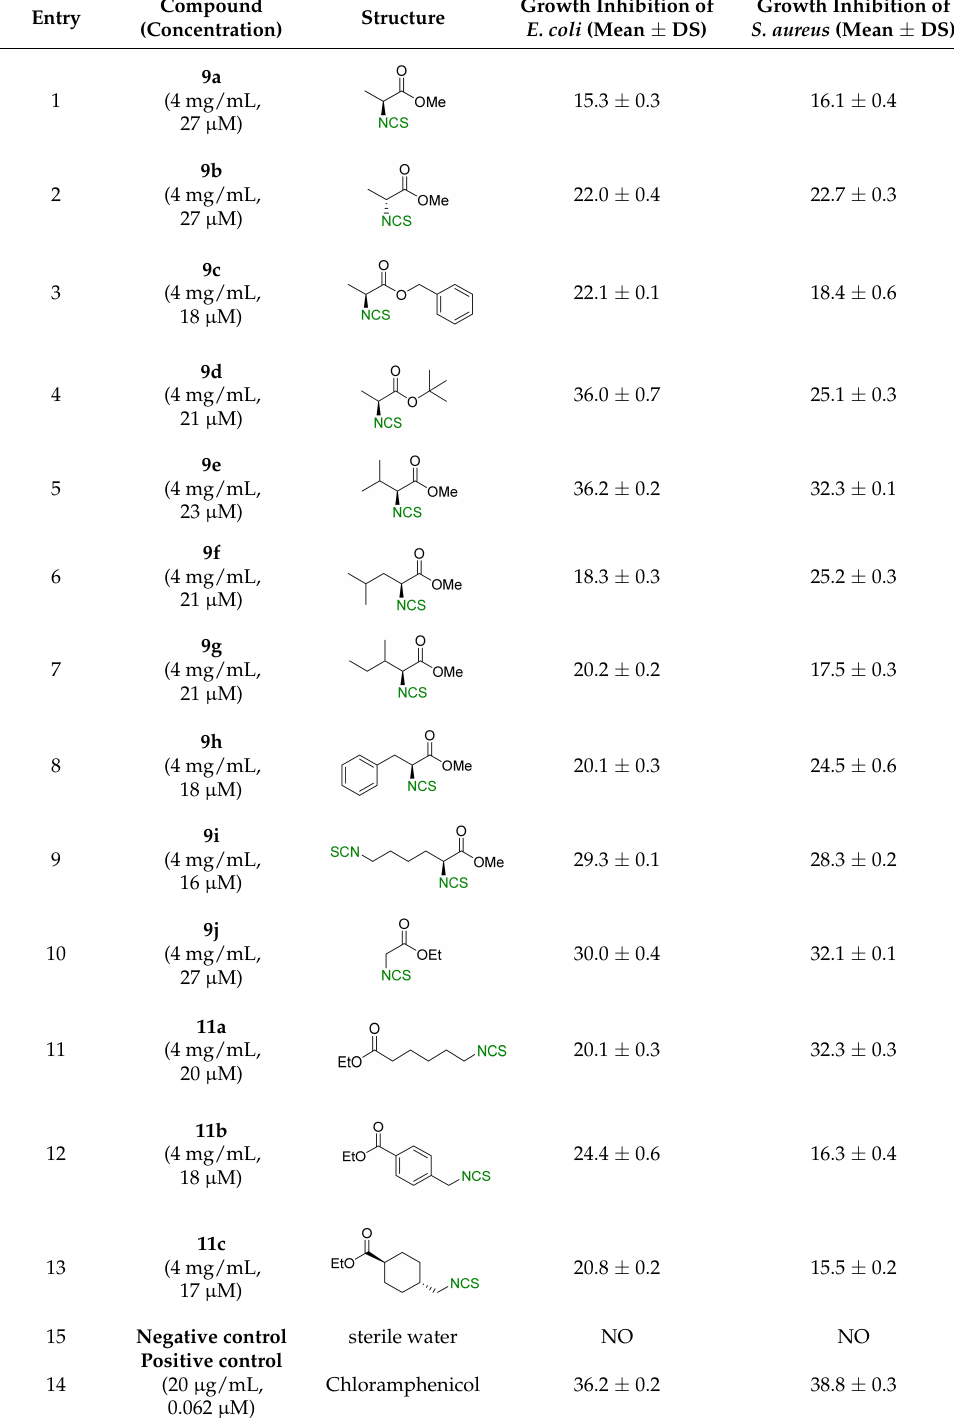
Table 5. Antibacterial activity of isothiocyanates 9a–j and 11a–c . Compound Entry (Concentration)